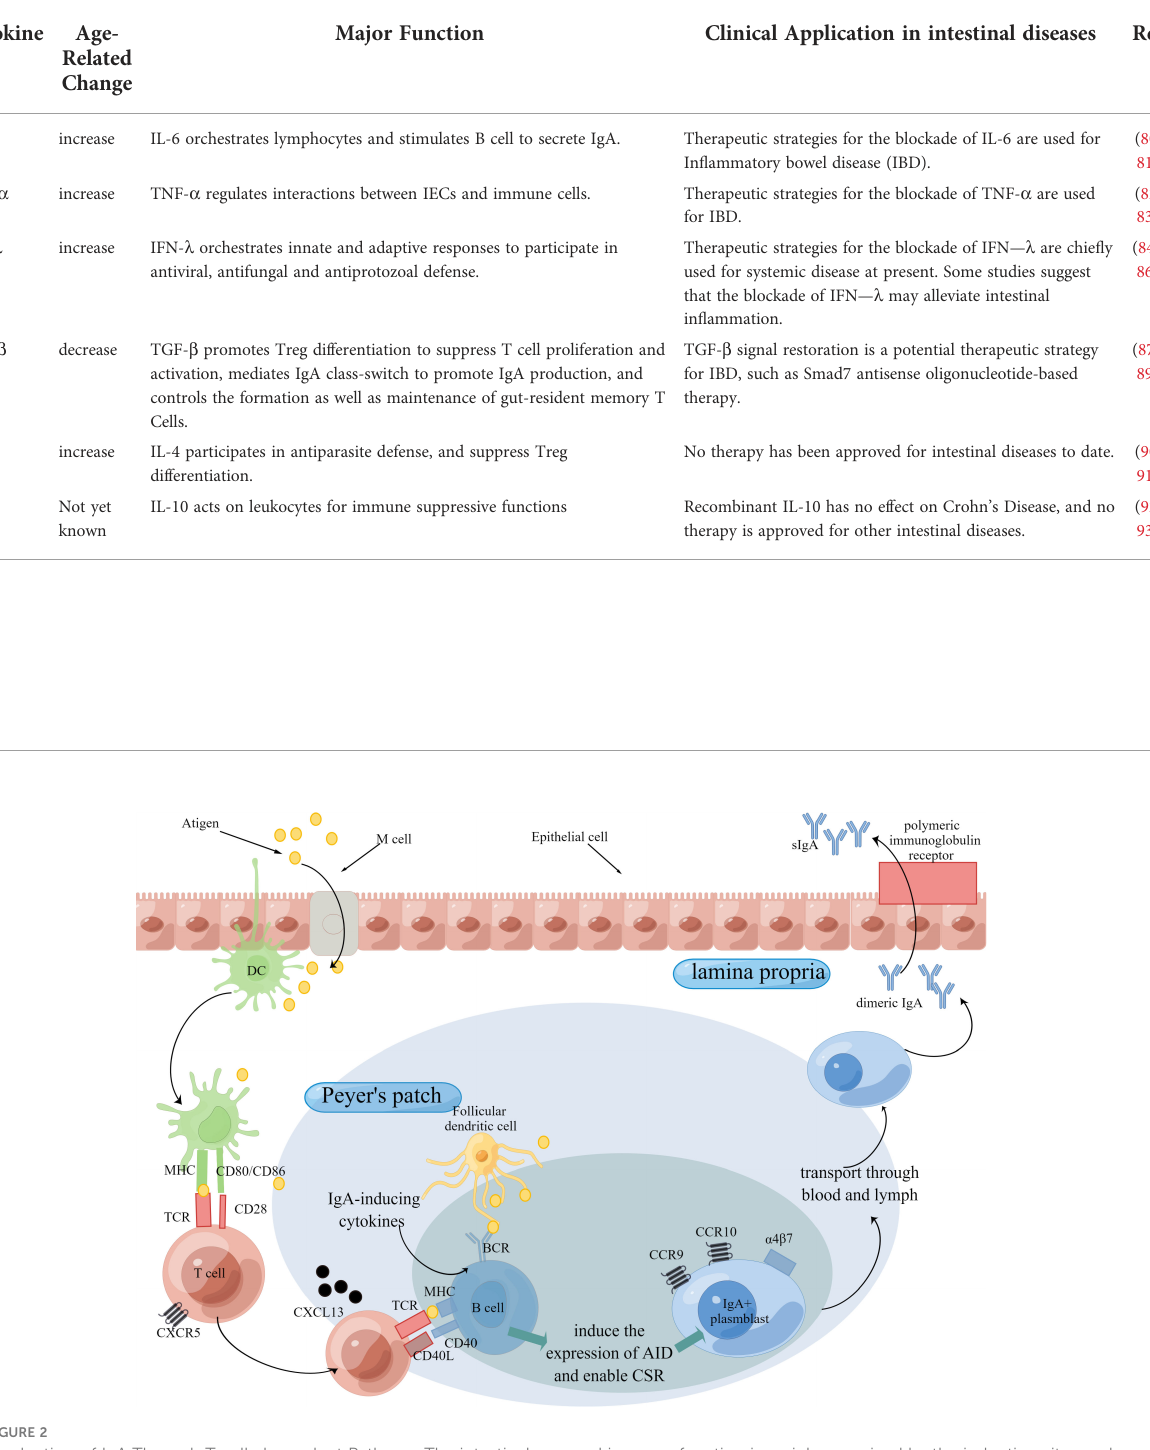
TABLE 1 Age-related cytokines affect the regulation of the immune response. Cytokine Age- Related Change IL-6 increase IL-6 orchestrates lymphocytes and stimulates B cell to secrete IgA. increase TNF- a regulates interactions between IECs and immune cells. Therapeutic strategies for the blockade of TNF- a are used